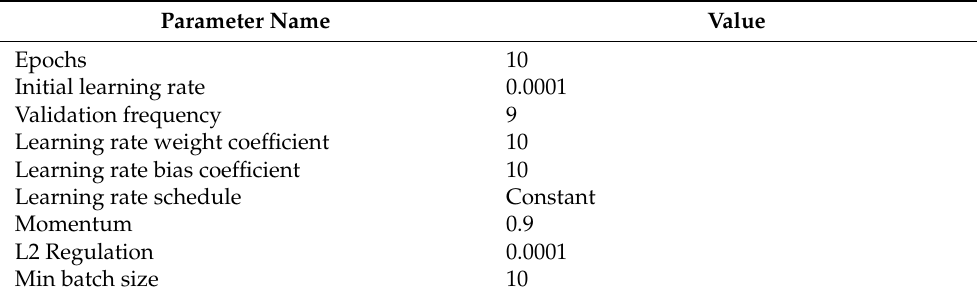
Table 4. Optimized parameters in this